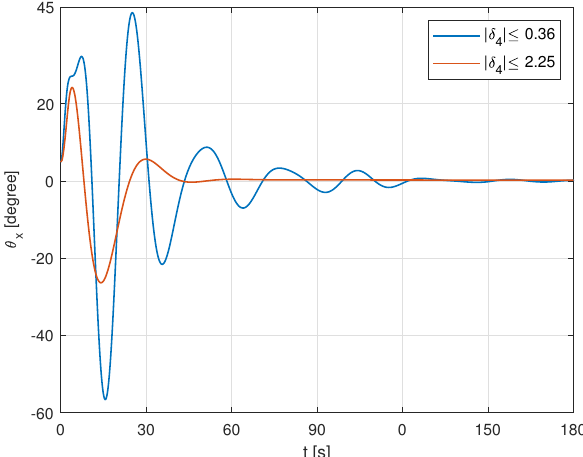
Figure 20. Angular position of the spacecraft.